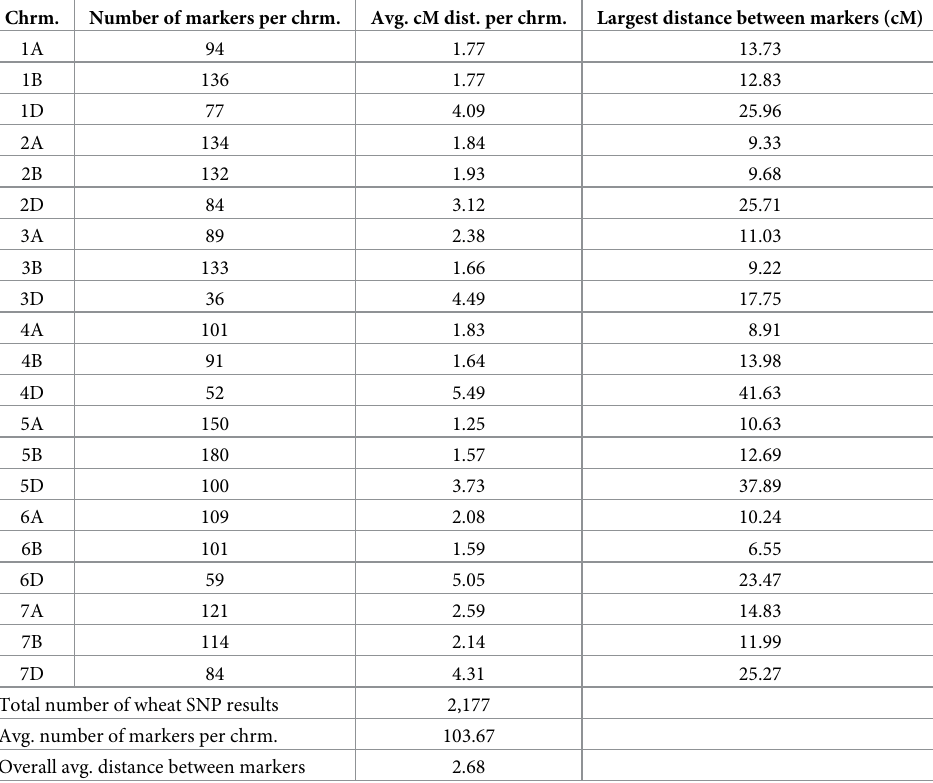
Table 1. Overview of current wheat SNP panel metrics per chromosome. Chrm. Number of markers per chrm. Avg. cM dist. per chrm. Largest distance between markers